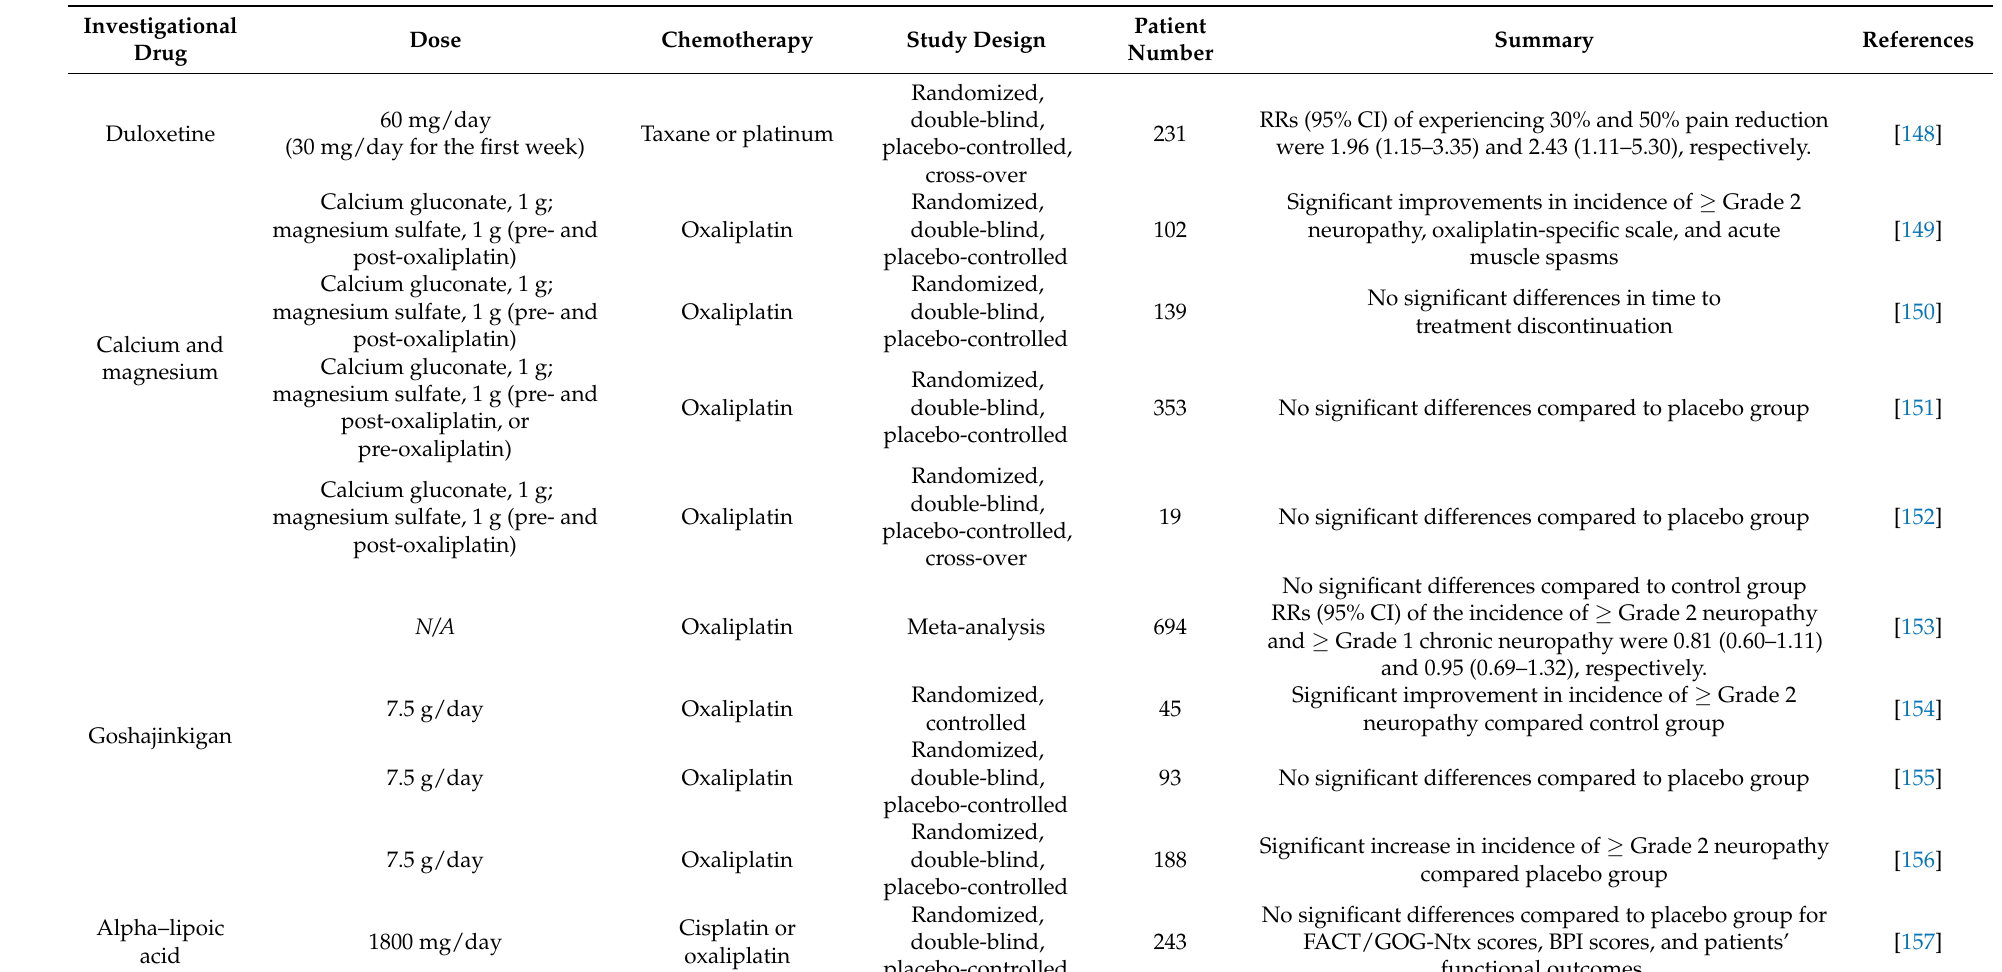
Table 2. The therapeutic drugs for oxaliplati-induced peripheral neuropathy in clinical